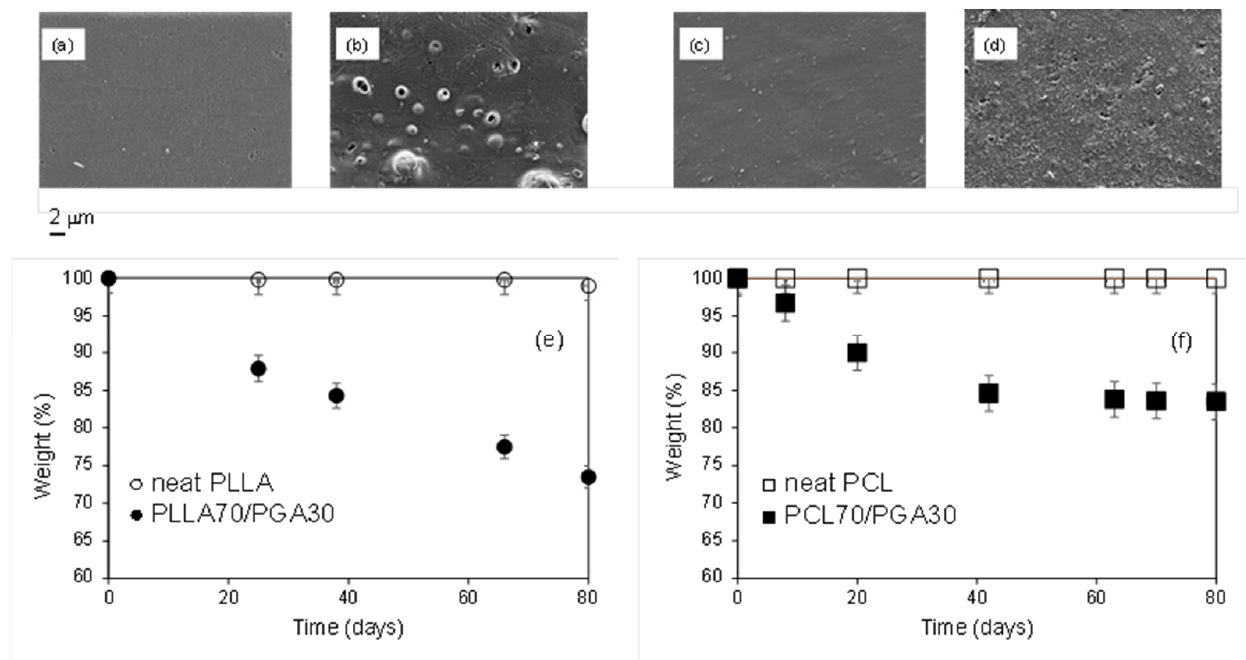
Figure 3. FE-SEM micrographs of treated films: ( a ) neat PLLA, ( b ) PLLA70/PGA30, ( c ) neat PCL, and ( d ) PCL70/PGA30. Weight loss percentage as a function of time of ( e ) films based on PLLA ( ○ neat PLLA, ● PLLA70/PGA30) and ( f ) films based on PCL ( □ neat PCL and ■ PCL70/PGA30).